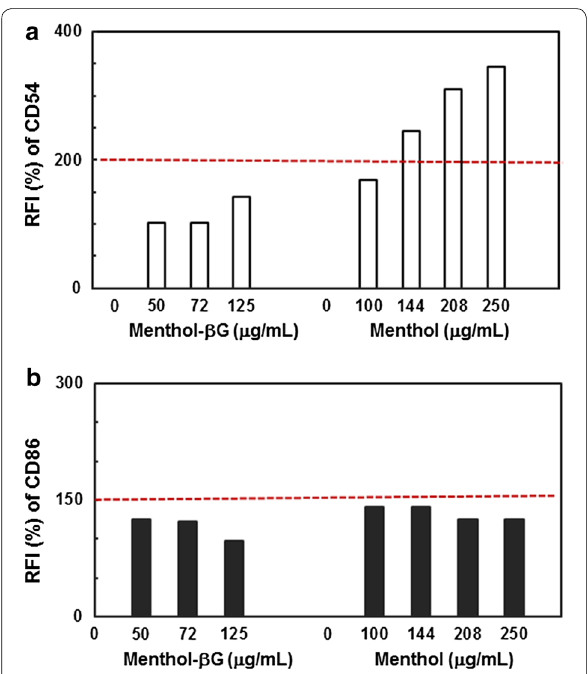
Fig. 5 In vitro skin sensitization test of ( and ( )‑menthol using human cell lines. The changes in CD54 ( a ) − and CD86 ( b ) expression on THP‑1 cells were measured after a